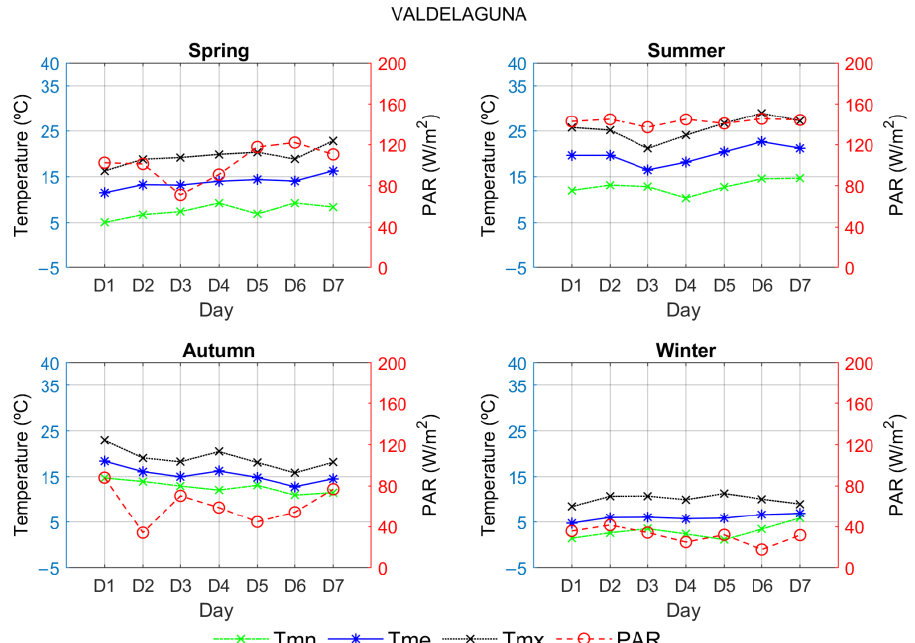
Figure A3. Daily variations of the daily mean values of temperature (mean, max, and min) and PAR for the selected TMWs for each season in Valdelaguna from 1991 to 2005. Table A1. Long-term data statistics for four sites.